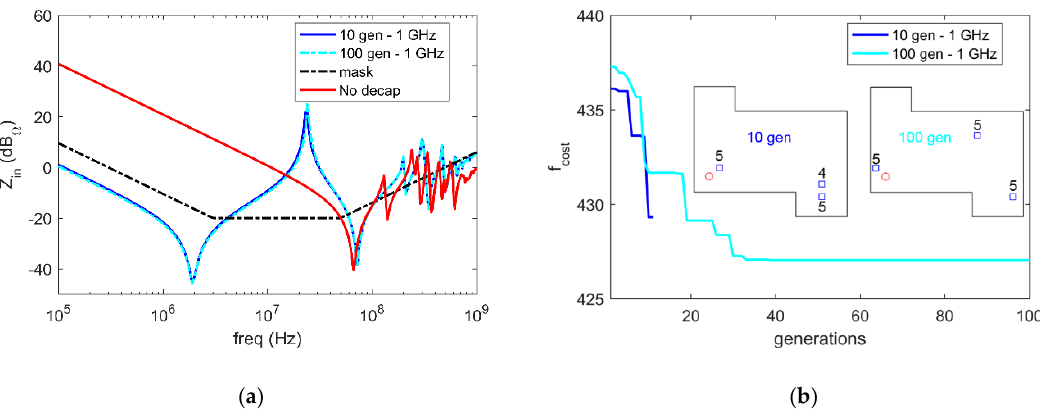
Figure 11. ( a ) Result of the optimization in DF PI up to 1 GHz after 10 generations (solid blue line) and 100 generations (dotted–dashed cyan line) compared with the mask and the case without decaps. ( b ) Cost function f cost as function of the number of generations when max gen = 10 and max gen = 100. The insets show the decaps placement after as max gen changes its value and the number of elementary decaps in each position. The red circle represents the input port and the blue squares the position for the decaps.